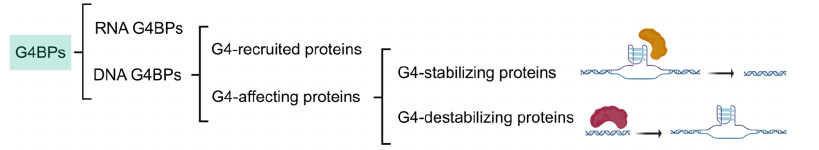
Figure 3. Classification of G4BPs. Categorization of G4BPs is based on the distribution of G4s in the genome, the functional relationships with G4s, and the structural effects on the G4 structure.